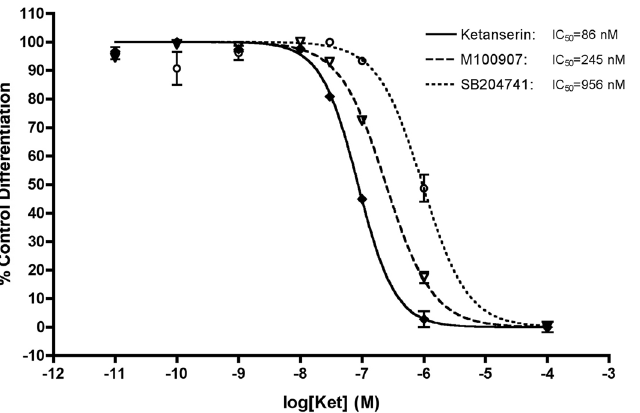
Figure 3. Dose–response effect of antagonists to block differentiation. The IC 50 value of ketanserin to block human adipocyte differentiation was 86 nM. The IC 50 values of M100907 (5-HT 2A selective) and SB204741 (5-HT 2B selective) were 245 nM and 956 nM, respectively. Oil red O staining was performed for each condition, and values compared to positive control cells for 100%, and negative control cells for 0% and presented as % control differentiation (n = 3 biological replicates for each data point ± SEM).